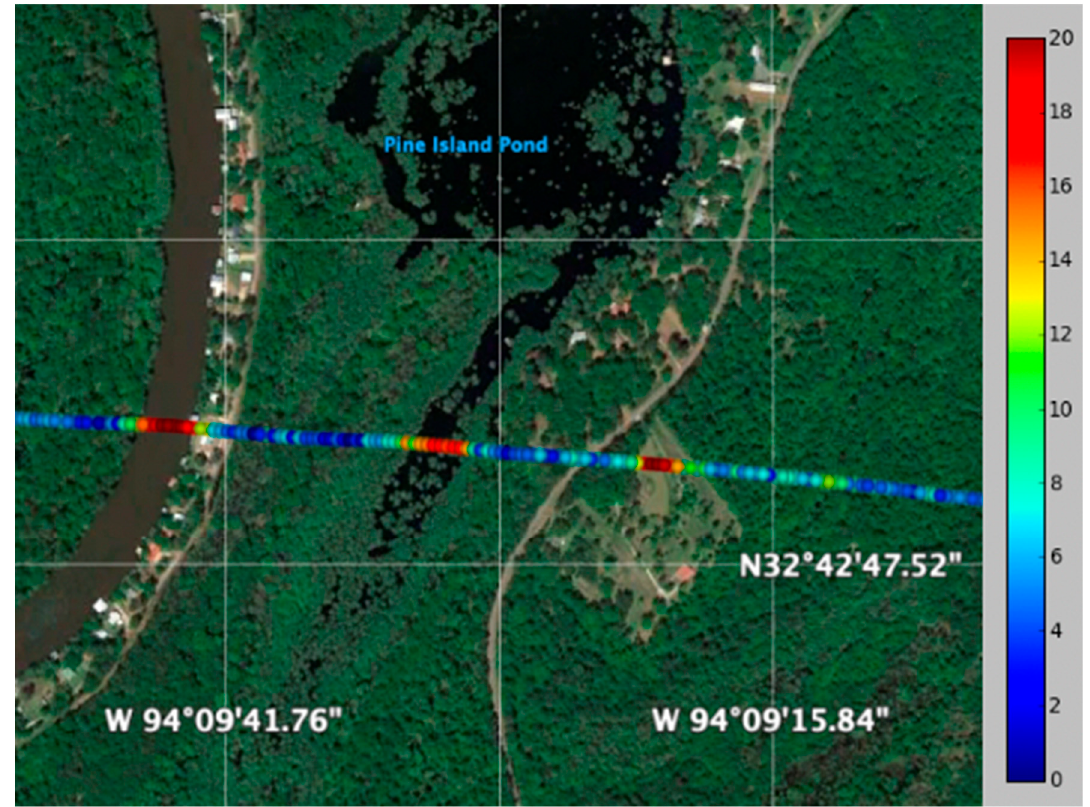
Figure 3. Westward ground track near Caddo Lake of PRN 23 over a Google Earth image from April 2017. The track’s calibrated power in dBs is color coded from low to high as blue to red respectively, over a 20-dB range.